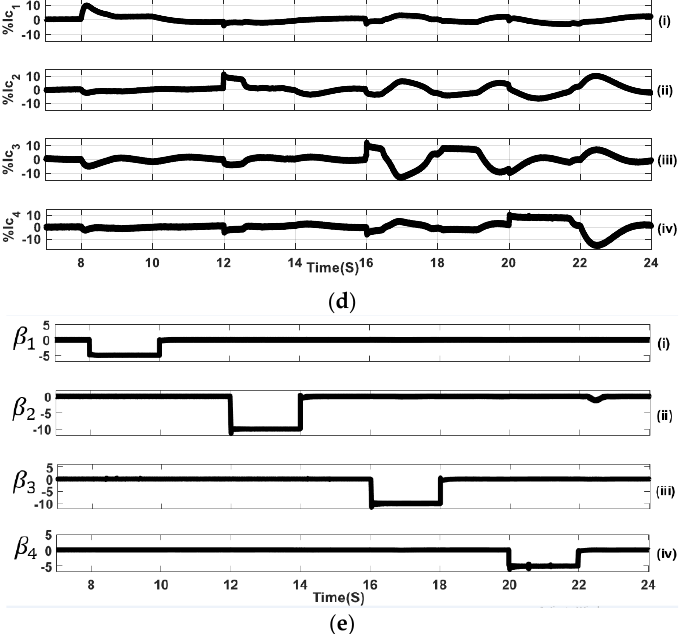
Figure 10. First case study: ( a ) DGU voltages v i , ( b ) DGU output currents I out i , ( c ) percentage errors in DGU voltages % Ve i , ( d ) percentage change in current sharing % Ic i , ( e ) voltage cyber-attack mitigation signals for DGUs, β i .